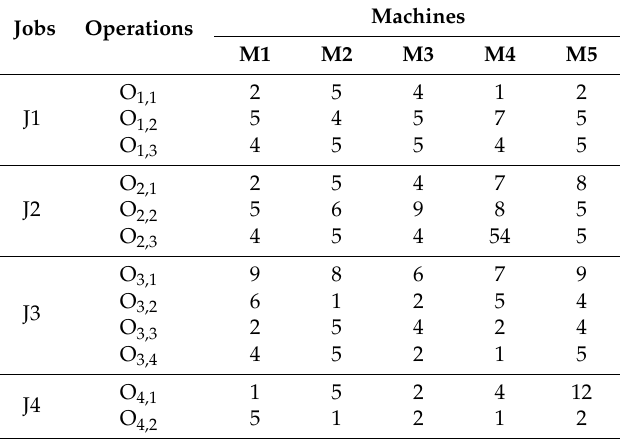
Table 3. Sample problem with four jobs and five